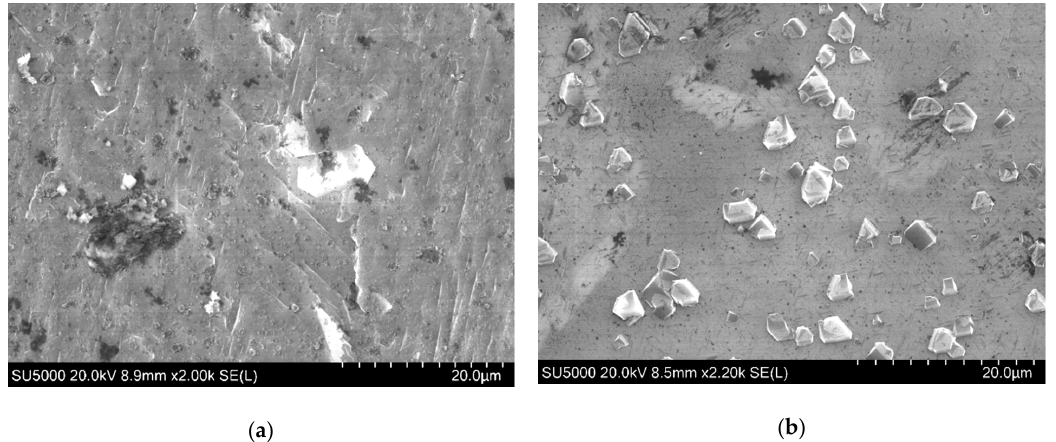
Figure 5. SEM images of the sample surfaces. ( a ) Sample 1, ( b ) Sample 2.